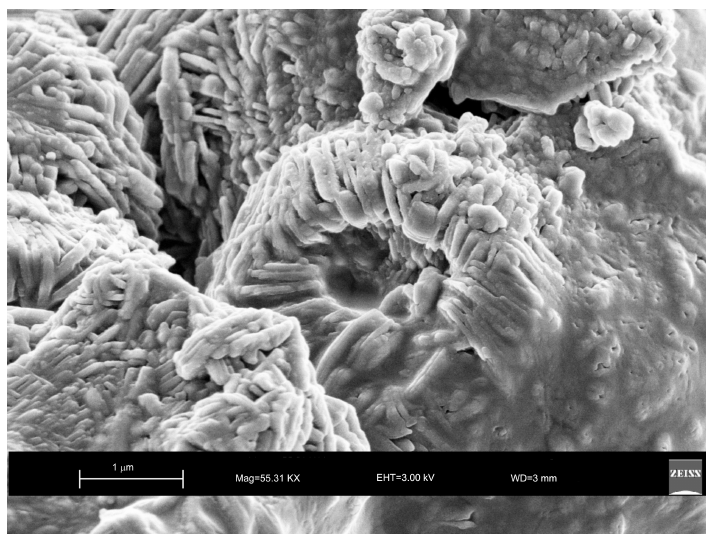
Figure 7. SEM image showing well defined plate morphology of sodalite crystal formed 6 months after hydrothermal treatment with ultrasonic.